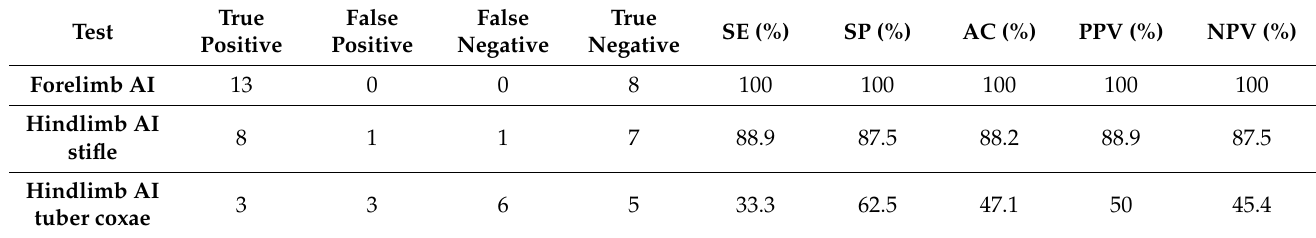
Table 5. Diagnostic test characteristics SE, SP, ACC, PPV and NPV of forelimb and hindlimb classifi- cation based on AI calculations when compared to the full clinical assessment (reference) in a study of 22 horses with lameness and eight horses without lameness (calculations of table contents based on Tables